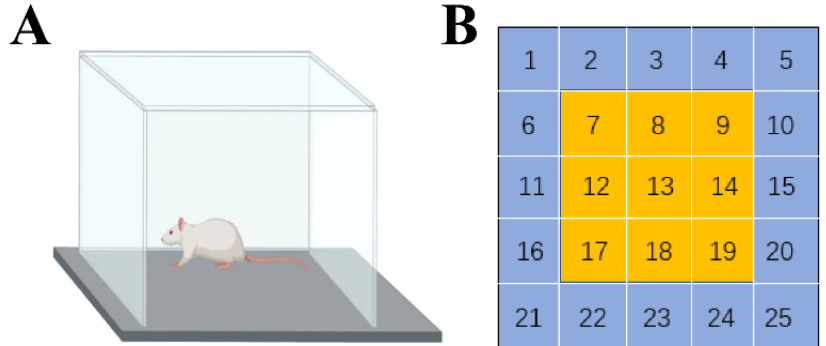
Figure 20. Diagram of the open field experimental setup. ( A ) Diagram of the open field reaction chamber; ( B ) diagram of the bottom partition of the reaction chamber (the bottom partition of the reaction chamber was divided into 25 cells, with the middle 9 cells defined as the central region and the remaining 16 cells as the edge region).